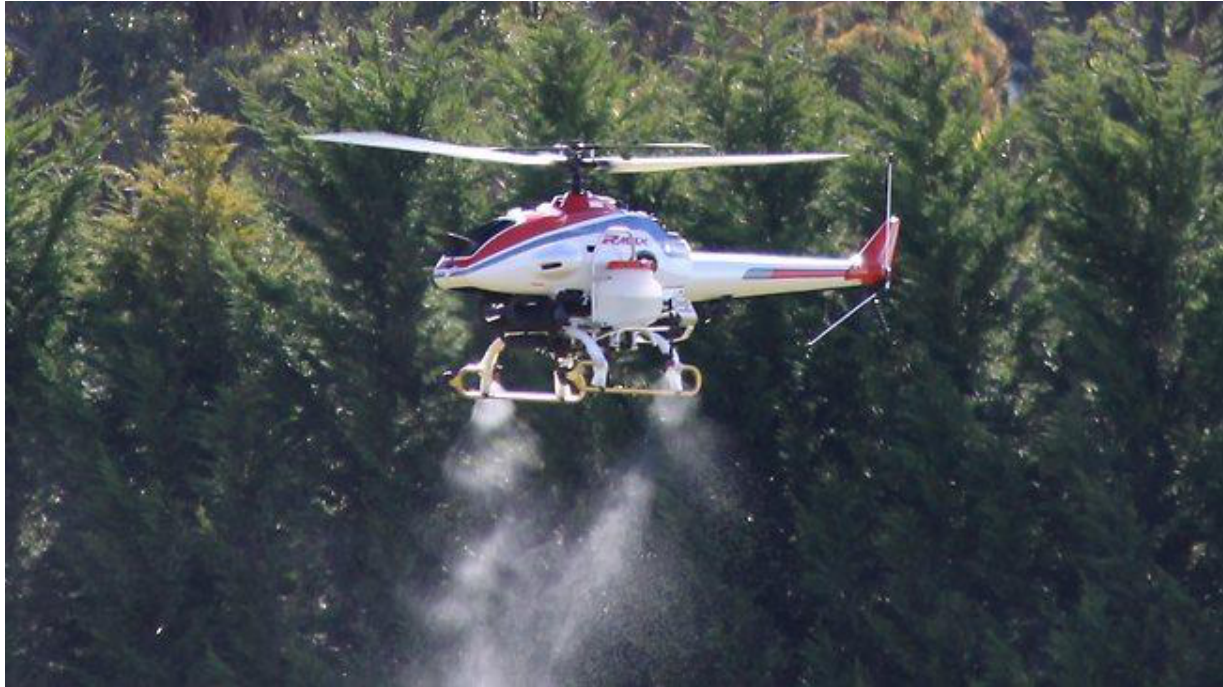
Figure 6. The Yamaha RMAX VTOL aircraft, shown with a pesticide/herbicide application sprayer payload used in precision agriculture. Image courtesy of Yamaha Motor